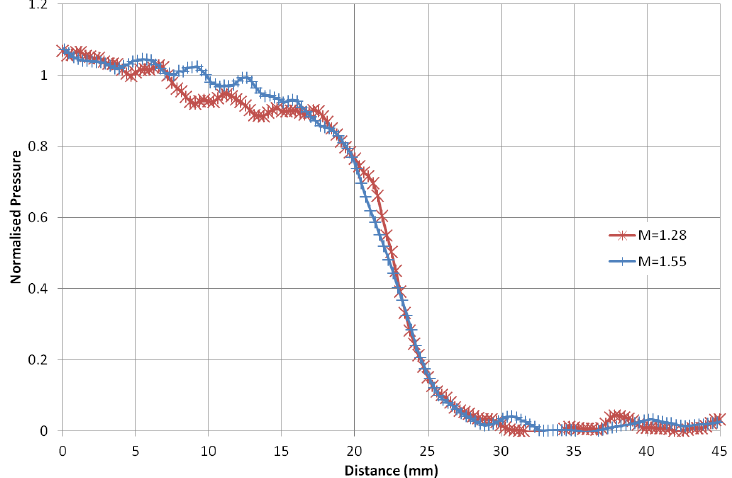
Figure 8. Normalised response of the PSP to two different shock